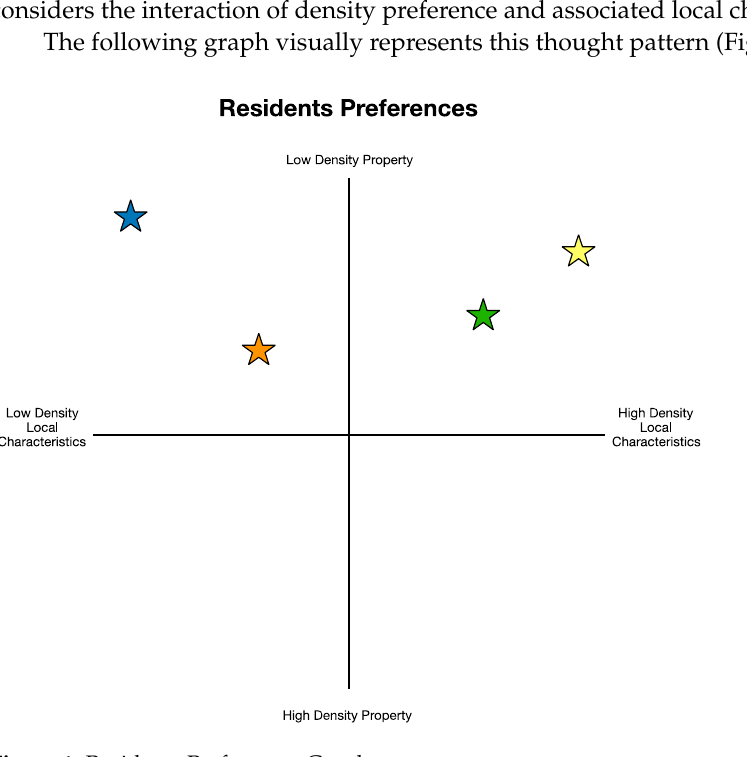
Figure 1. Residents Preferences Graph.